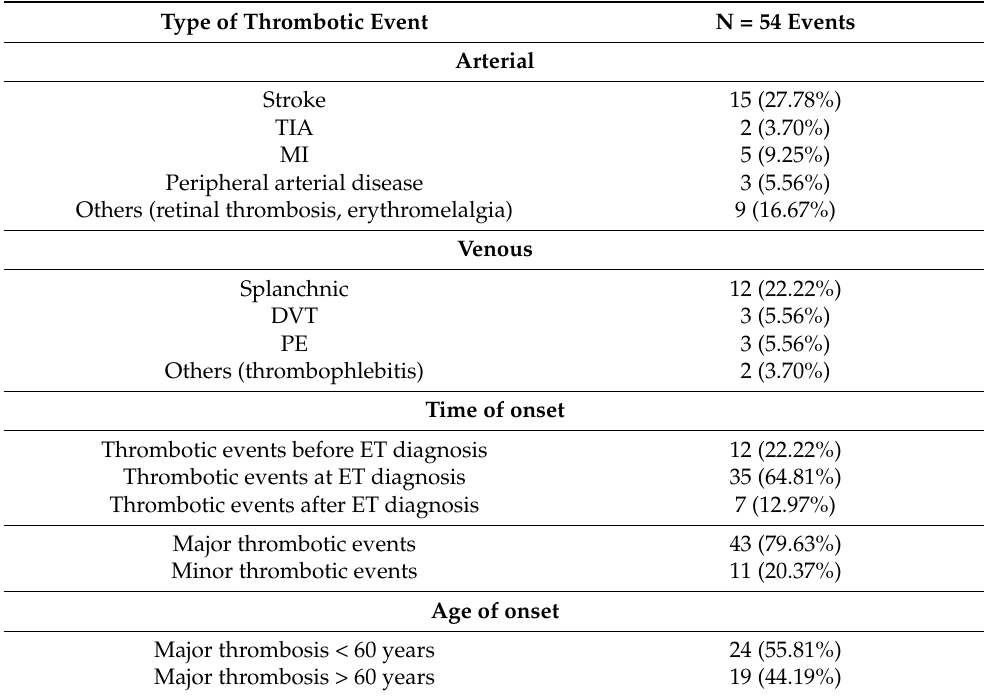
Table 2. Thrombotic